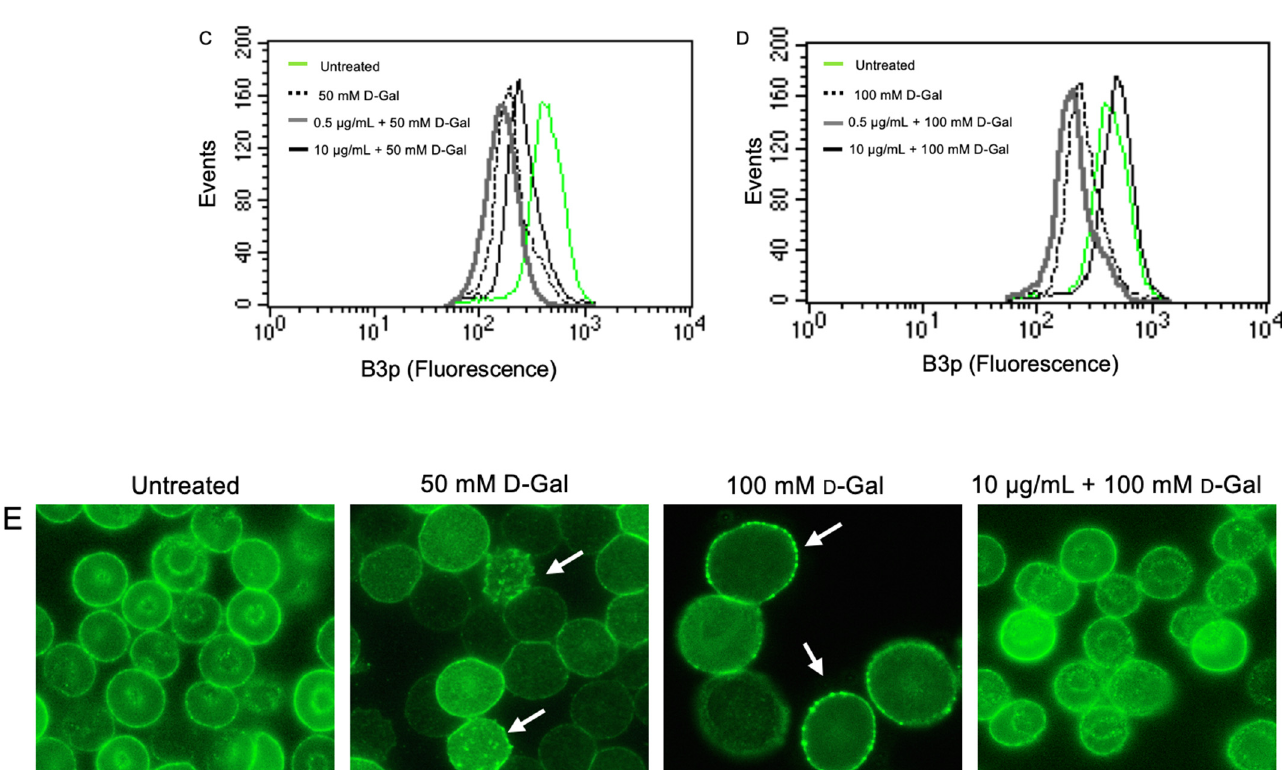
Figure 9. Flow cytometry immunofluorescence of B3p protein expression. Erythrocytes were treated for 24 h with 50 ( A ) or 100 mM ( B ) D -Gal, with or without pre-incubation for 1 h with 0.5 or 10 µg/mL freeze-dried Açaì extract. Histograms represent median values of fluorescence intensity. In ( C , D ), typical flow cytometry measurements of B3p expression of a representative experiment are shown. In ( E ), representative micrographs obtained by flow cytometry immunofluorescence showing B3p distribution in erythrocytes left untreated, treated with 50 mM or 100 mM D -Gal, or alternatively, pre-treated with 10 µg/mL freeze-dried Açaì extract, and then exposed to 100 mM D -Gal are shown. Samples were observed with a 100x objective. Note the significant morphological changes in both 50 and 100 mM D -Gal (arrows). ns, not statistically significant versus untreated; ***, p < 0.001 versus untreated (control); °°°, p < 0.001 versus 100 mM D -Gal, one-way ANOVA with Bonferroni’s multiple comparison post-hoc test ( n = 8).